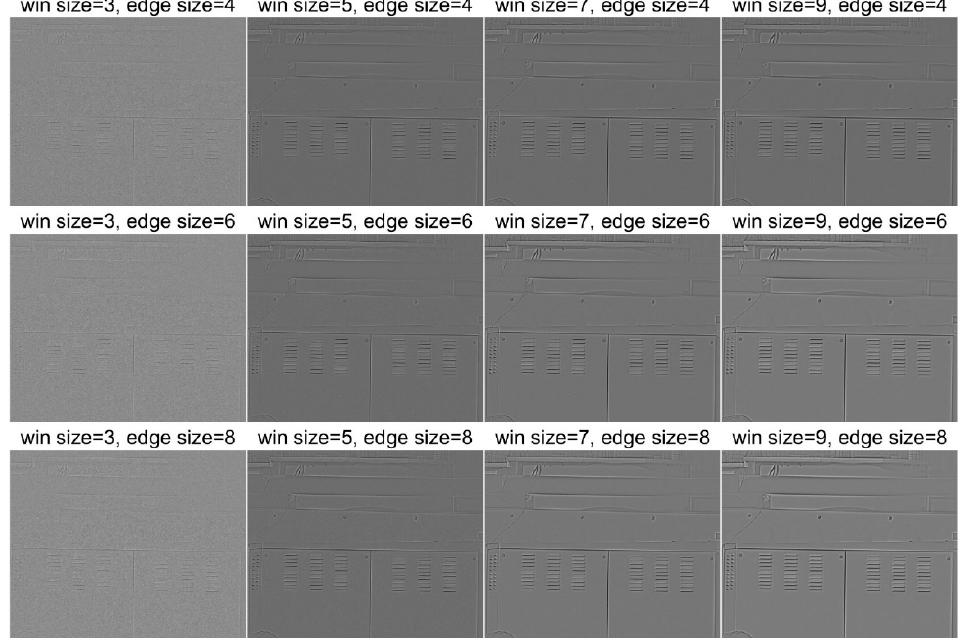
Figure 7. DoG filtering results with different parameters.